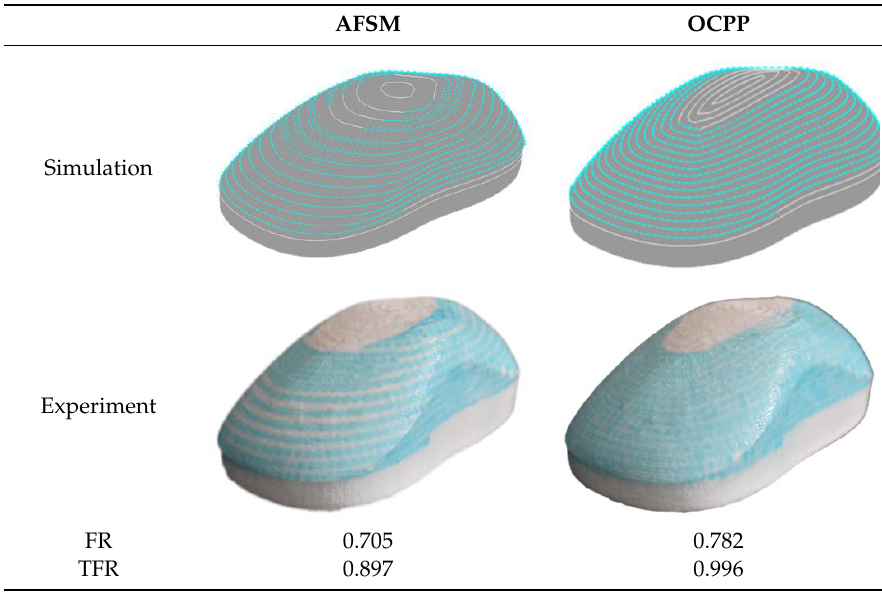
Table 2. Comparison between the AFSM and OCPP for a freeform surface.